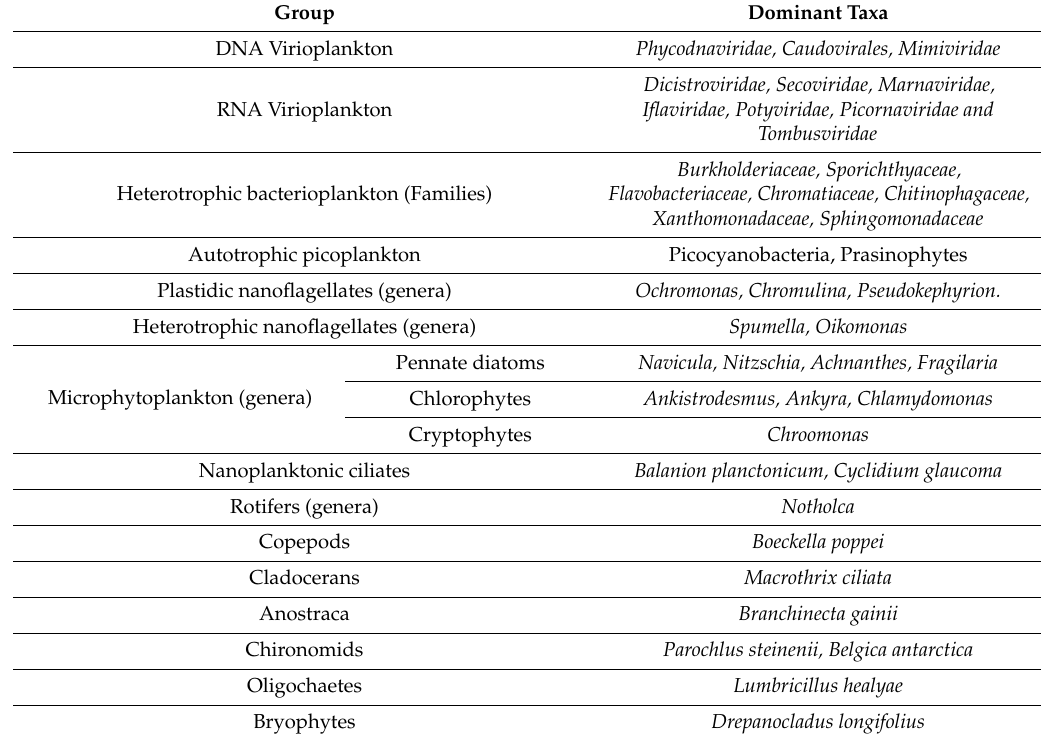
Table 2. Dominant taxa, per groups, in the water column and benthos of Lake Limnopolar during the ice- free summer periods. Data compiled from